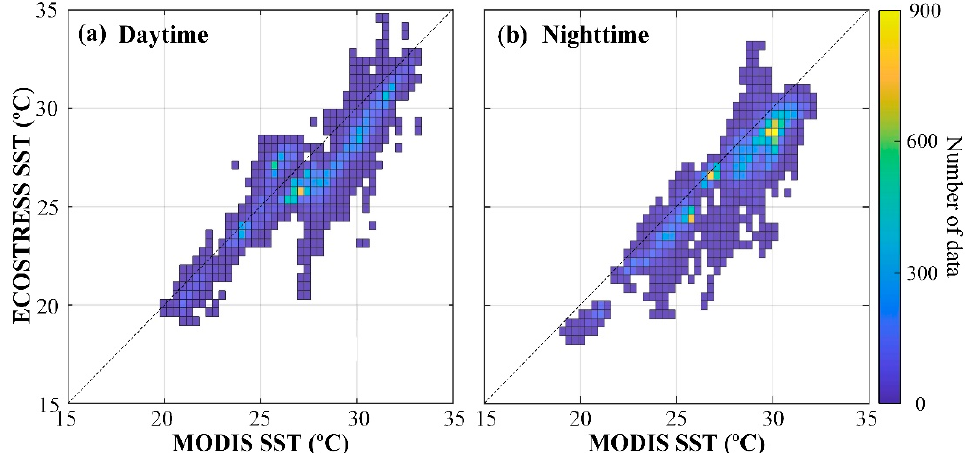
Figure 7. Comparisons between gridded ECOSTRESS SST (to match MODIS pixels) and MODIS SST from 33 image pairs over the FB between August 2018 and August 2020 for daytime ( a ) and nighttime ( b ) data. Color represents the number of pixels from both ECOSTRESS and MODIS.